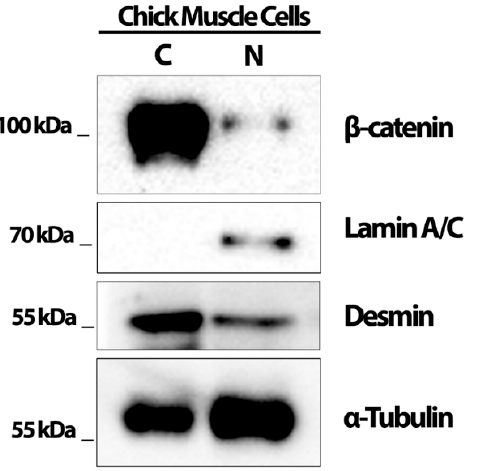
Figure 7. Beta-catenin is predominantly found in the cytoplasm of chick muscle cells. Cytoplasmic (C) and nuclear (N) fractions were isolated from chick myogenic cells grown for 48 h. Nuclear and cytoplasmic fractions were submitted to SDS-PAGE and immunoblot against beta-catenin, lamin A/C, desmin, and alpha-tubulin. Note the presence of lamin A/C exclusively in the nuclear fraction, whereas beta-catenin was predominantly detected in the cytoplasmic fraction.